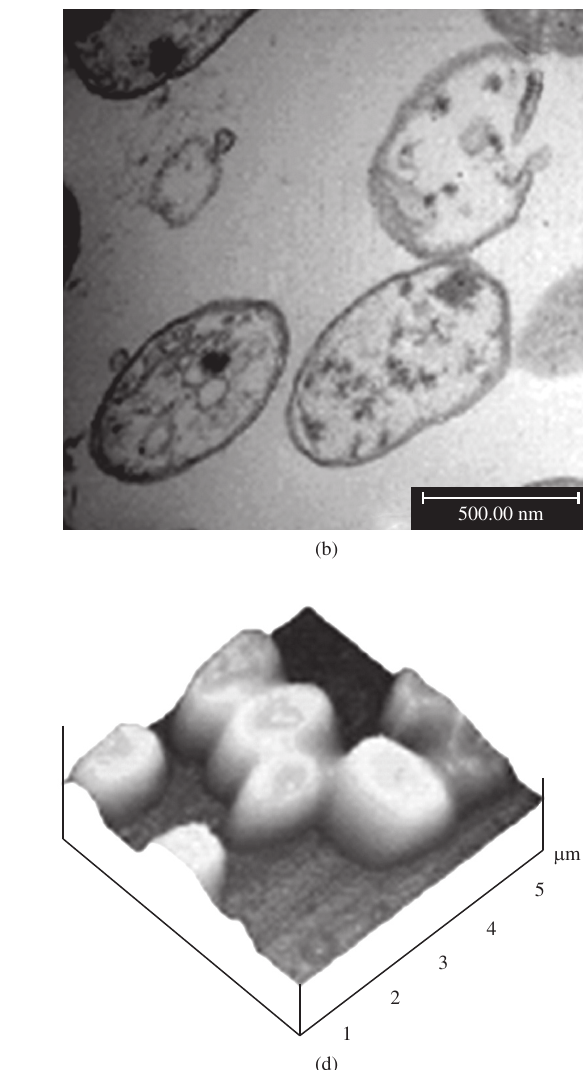
/L) containing solution 38 . 2